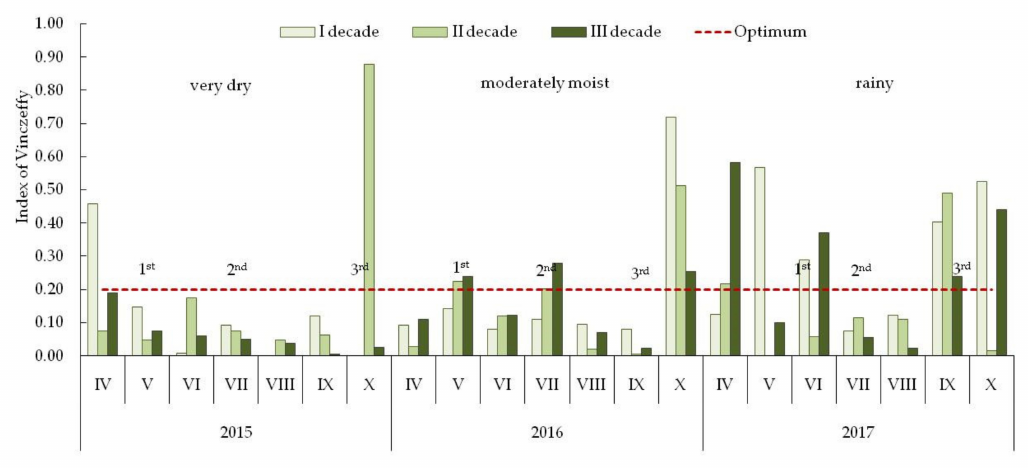
Figure 1. Vincze ff y hydrothermal index for subsequent 10 days of month (decade: I, II, III) during the vegetation period in 2015–2017 (1st, 2nd,